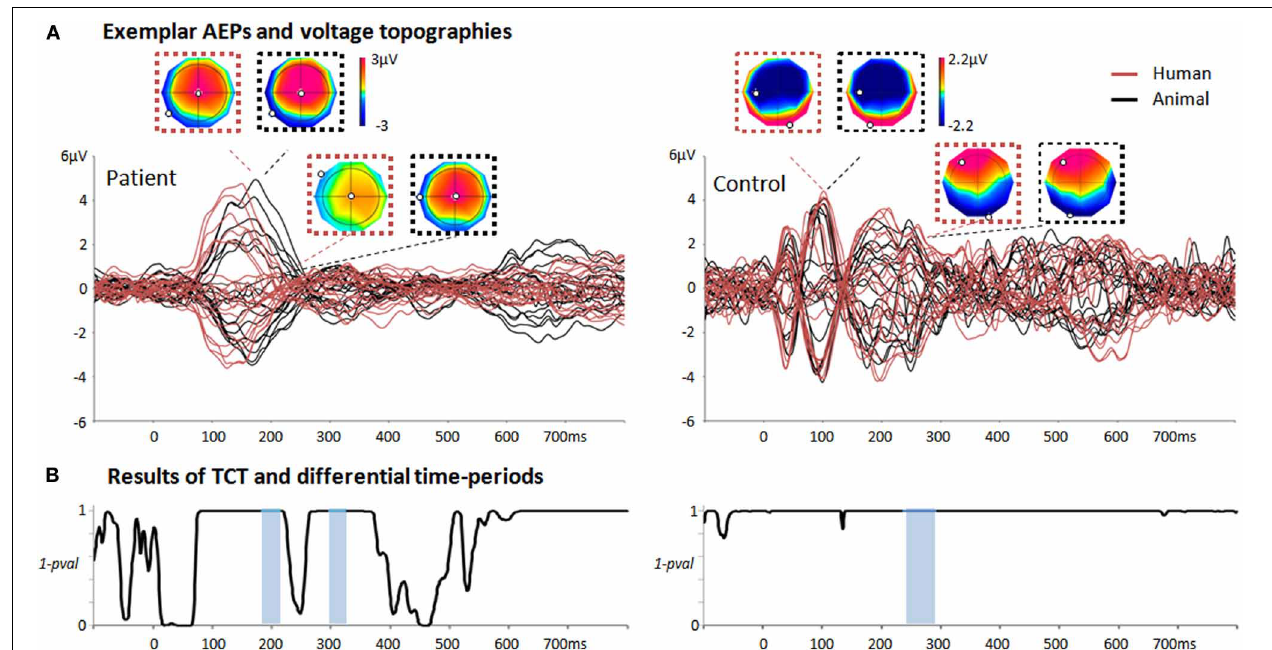
FIGURE 2 | Summary of the single-trial EEG analysis when comparing responses to animal/human vocalizations in two exemplar individuals. (A) Average auditory evoked potentials of one patient recorded during TH and one control subject inresponse tohuman (red) andanimal (black)vocalizations. For the patient, the voltage topographies correspond to the first peak of GFP and to the first period of differential activity as evaluated by the single-trial EEG analysis(184–214mspost-stimulusonset).Forthecontrol,thefirsttwovoltage topographies correspond to the N100; the second two correspond to the